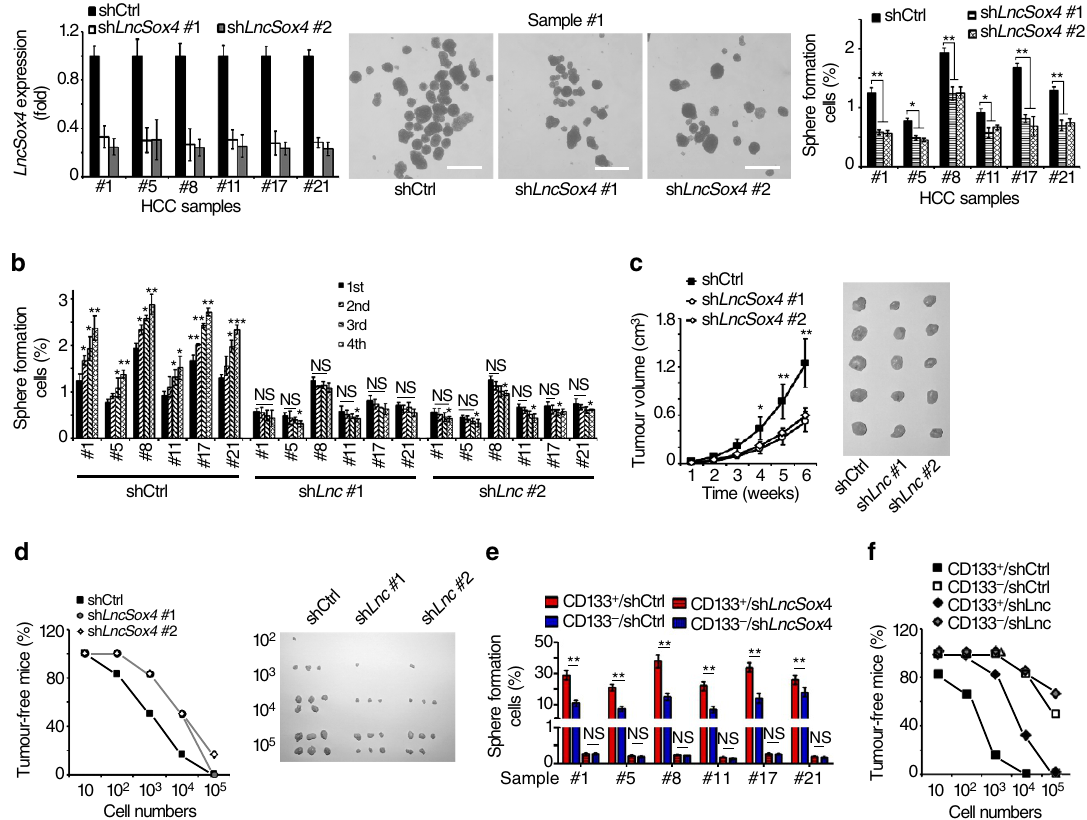
Figure 2 | LncSox4 is required for liver TIC self-renewal. ( a ) LncSox4 plays an essential role in sphere formation. LncSox4 -silenced primary HCC cells were established (left panel) using pSiCoR lentivirus, followed by sphere formation assays. Representative sphere pictures were shown in middle panels and calculated TIC ratios were shown in the right panels. Scale bars, 500 m m. ( b ) Serial sphere formation of LncSox4 -silenced (shLnc) and control (shCtrl) primary HCC cells. For each sphere formation assays, 5,000 primary HCC cells (the 1st generation sphere formation) or signal sphere cells (the second, third, fourth generations) were used. ( c ) LncSox4 is required for HCC propagation. A total of 1 (cid:2) 10 6 LncSox4 -silenced or control cells were subcutaneously injected into BALB/c nude mice on the back, and tumour volumes were measured at the indicated time points. The tumour pictures were shown in right panels. ( d ) LncSox4 participates in HCC initiation. 10, 1 (cid:2) 10 2 , 1 (cid:2) 10 3 , 1 (cid:2) 10 4 and 1 (cid:2) 10 5 LncSox4 -silenced or control cells were subcutaneously injected into BALB/c nude mice on the back and tumour formation was observed three months later. Tumour-free mice ratios and tumour pictures were shown. ( e , f ) sphere formation ( e ) and tumour-initiation ( f ) assays of LncSox4 -silenced liver TICs. CD133 þ liver TICs and CD133 (cid:3) non-TICs were enriched from primary HCC cells using flow cytometer, followed by infection with LncSox4- silenced and control pSiCoR lentivirus. For sphere formation, 5,000 cells were incubated in FBS-free medium for 2 weeks. For tumour initiation, 10, 1 (cid:2) 10 2 , 1 (cid:2) 10 3 , 1 (cid:2) 10 4 and 1 (cid:2) 10 5 cells were subcutaneously injected into BALB/c nude mice on the back for 3 months. Data are shown as means ± s.d. Two tailed Student’s t -test was used for statistical analysis. * P o 0.05; ** P o 0.01; *** P o 0.001; NS, not significant. P o 0.05 was considered significant. Data are representative of three independent experiments. NATURE COMMUNICATIONS|7:12598|DOI: